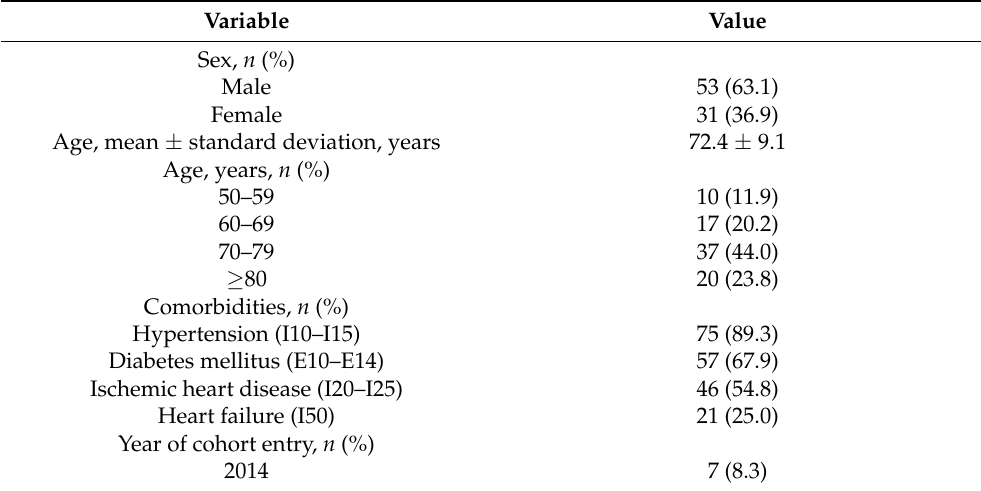
Table 1. Characteristics of the study population ( n = 84).